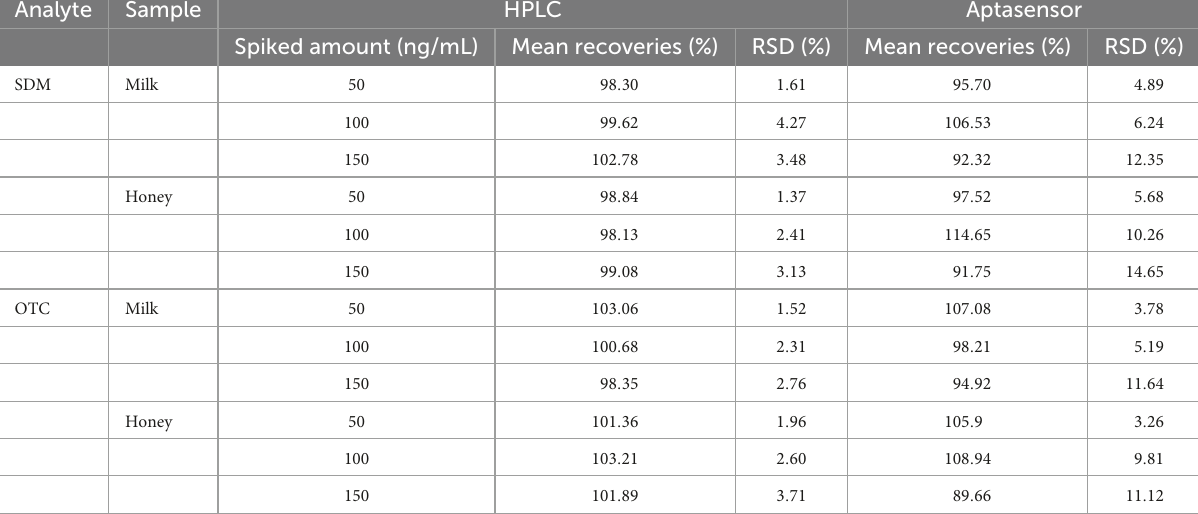
TABLE 1 A brief overview of recently reported methods for the determination of sulfadimethoxine (SDM) and oxytetracycline (OTC).